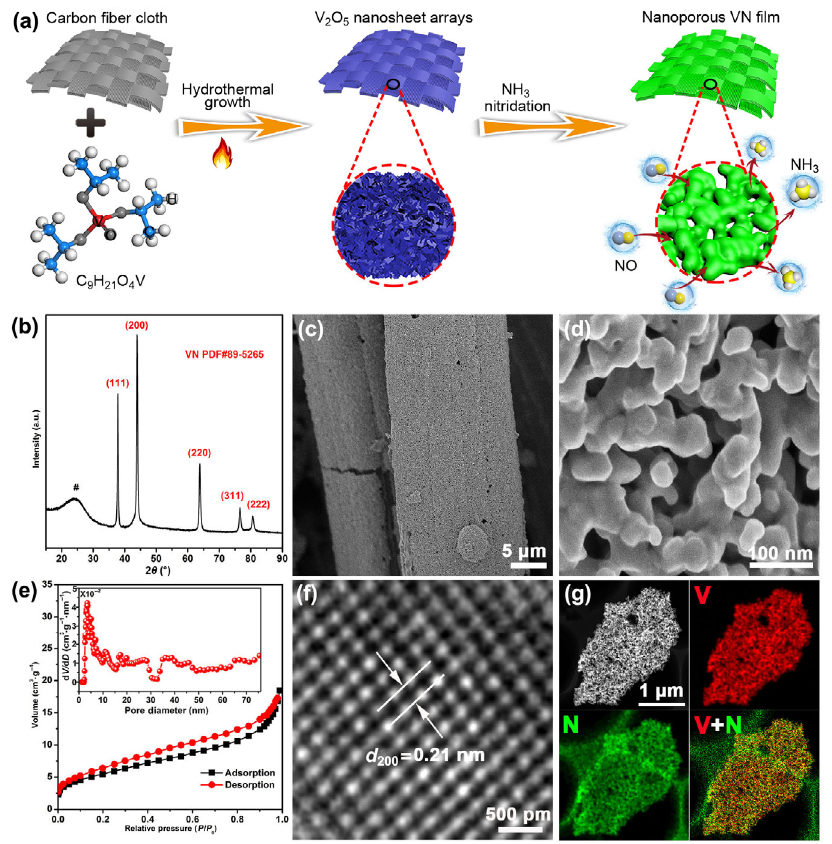
Figure 1 Synthesis and structures of np-VN/CF. (a) Schematic diagram of the synthesis process. (b) XRD pattern. (c) and (d) Low- and high-magnification SEM images. (e) N 2 adsorption/desorption isotherms and the corresponding pore size distribution curve. (f) High-resolution TEM image. (g) EDS elemental mapping images of V and